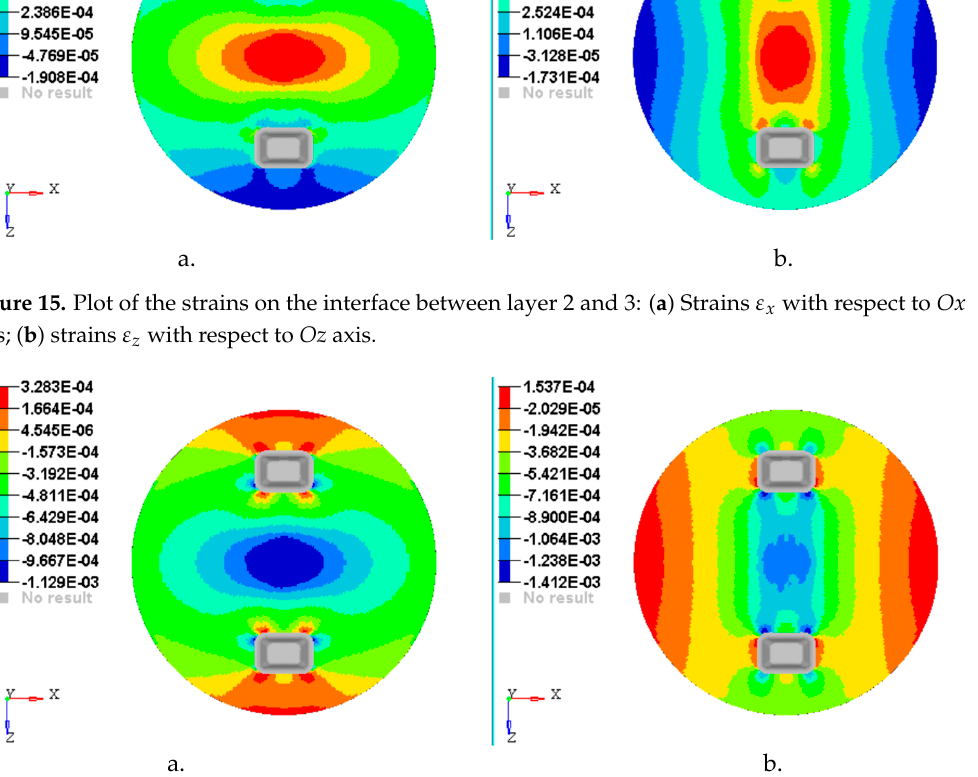
a. b. a. b. Figure 16. Plot of the strains on the interface between layer 3 & 4: ( a ) Strains ε x with respect to Ox axis; Figure 16. Plot of the strains on the interface between layer 3 & 4: ( a ) Strains x ε with respect ( b) Strains ε z with respect to Oz axis. Materials 2019 , 11 , x FOR PEER REVIEW 12 of 17 Figure 16. Plot of the strains on the interface between layer 3 & 4: ( a ) Strains x ε with respect to Ox axis; ( b) Strains z ε with respect to Oz axis. to Ox axis; ( b) Strains z ε with respect to Oz axis.